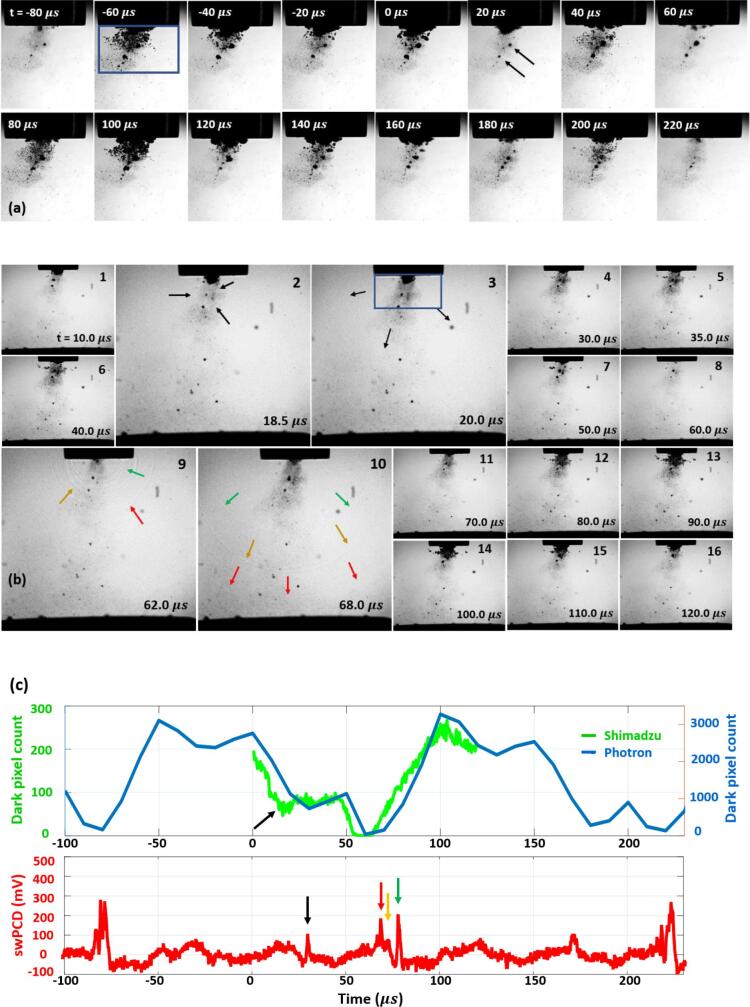
Sample data representing cavitation characterisation and data-registration between: (a) Photron imaging at 1 × 105 fps, (b) shadowgraphic Shimadzu imaging at 2 Mfps. The same two satellite clusters are arrowed in (a) at 20 µs and (b) at 10 µs, with the shock wave generated by the upper cluster also arrowed at 18.5 and 20.0 µs. Coloured arrows at 62.0 and 68.0 µs track shock wave fronts generated by primary sub-cluster collapses, as they propagate through the FOV. Scale for both imaging data perspectives is provided by the 6.4 mm-Ø horn-tip, and t = 0 μs is determined by the start of the Shimadzu imaging. (c) dark pixel counting for both imaging sequences and swPCD measurements.